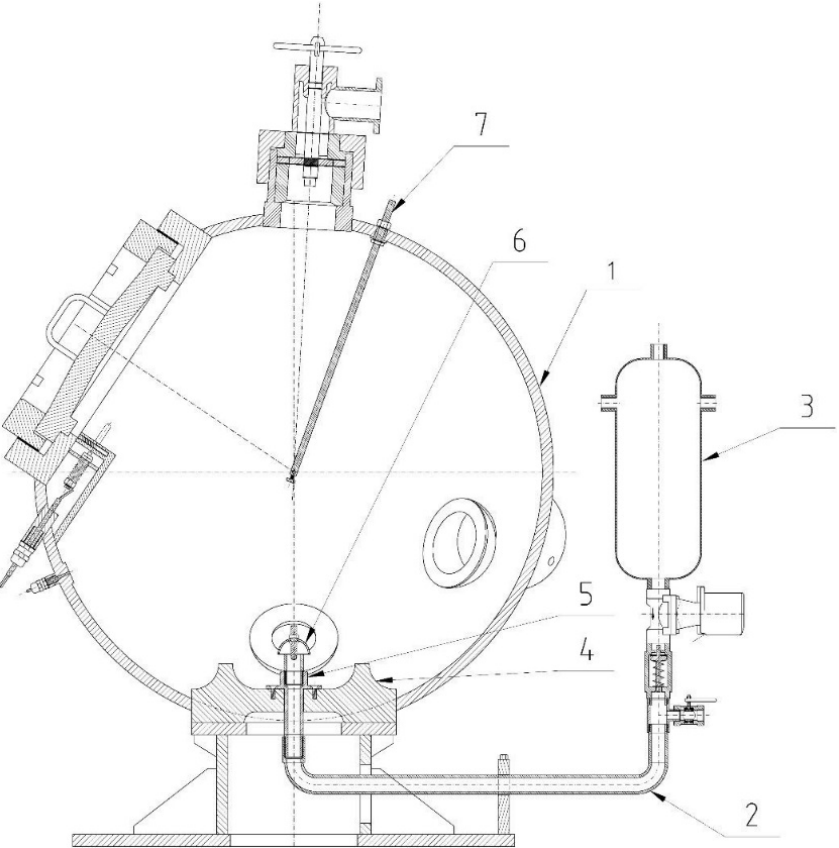
Figure 6. Cross-section of the KV 150M2 explosion chamber (1, chamber; 2, disperser tube; 3, air pressure vessel; 4, dispersing plate; 5, disperser; 6, air flow reverser; 7, igniter rod).